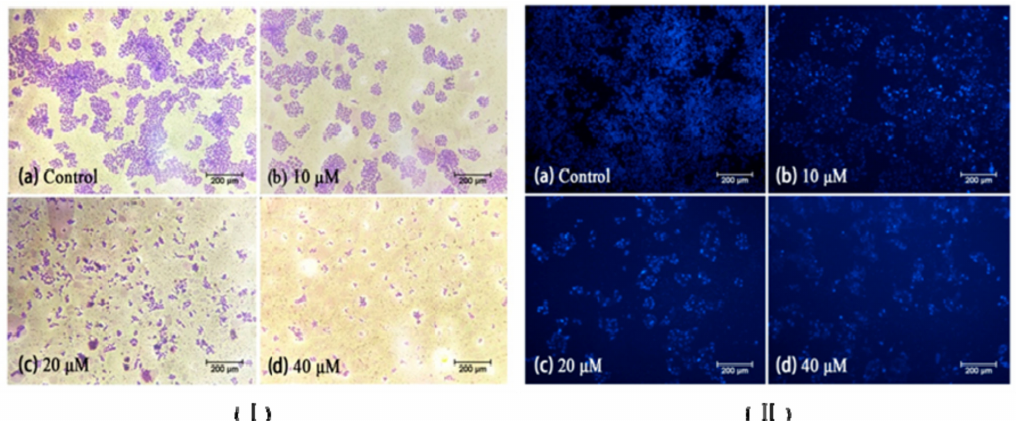
Figure 2. Gimesa ( I ) and DAPI ( II ) staining on Bel-7402 cells induced by compound 14 with different concentrations: (100 × ): (a) control group; (b) 10 µ M; (c) 20 µ M; (d) 40 µ M. The cell morphology was observed under the fluorescence microscope. The most representative fields are shown.